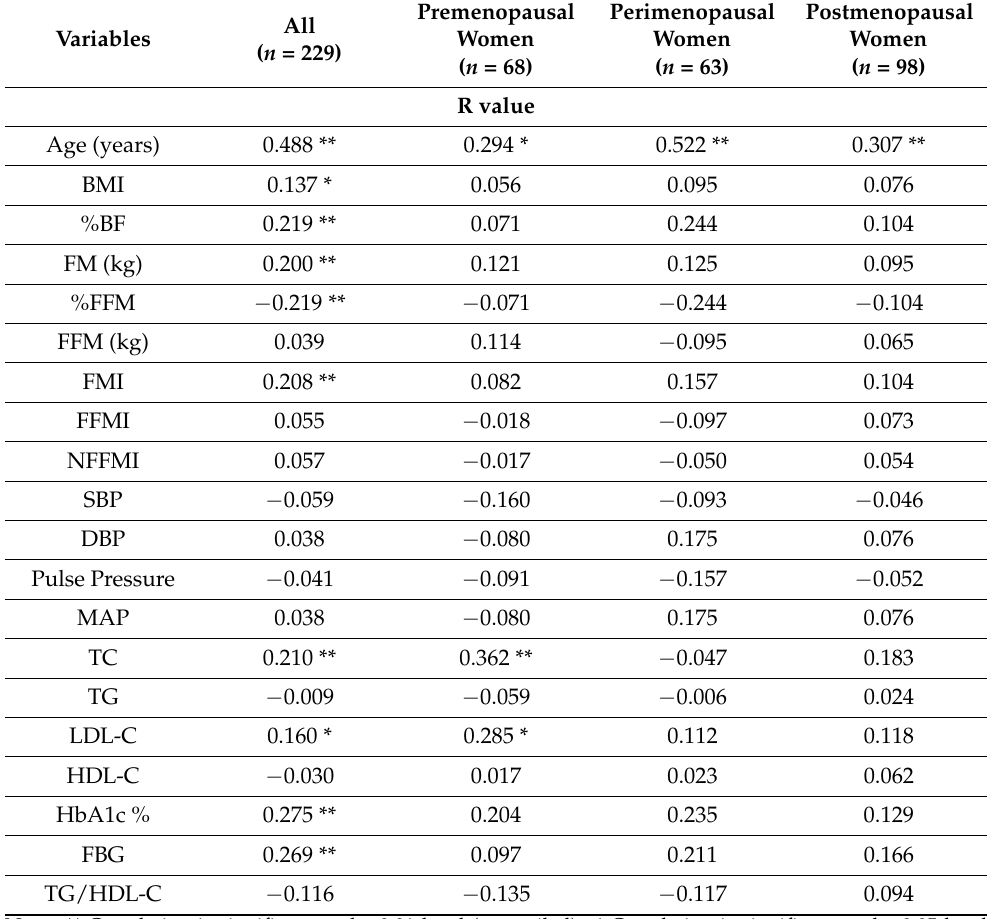
Table 2. Spearman’s correlations of lipoprotein(a) levels with demographics, adiposity indices, and lipid